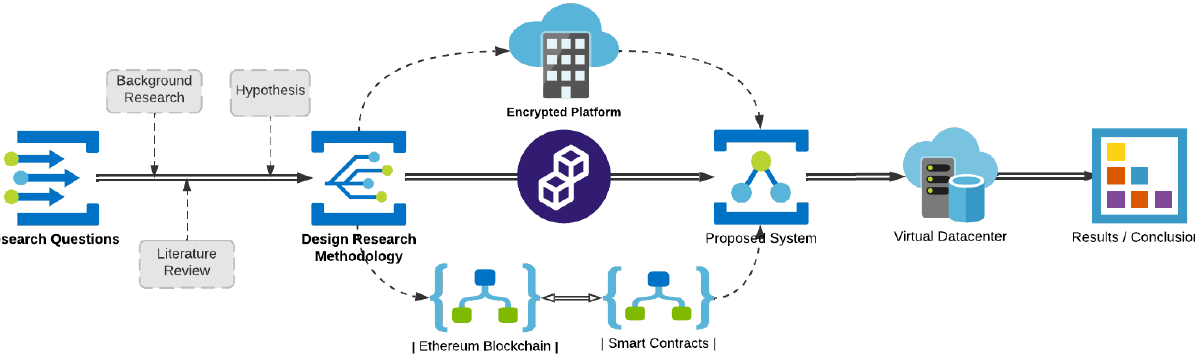
Figure 2. Flowchart of Proposed Methodology/System